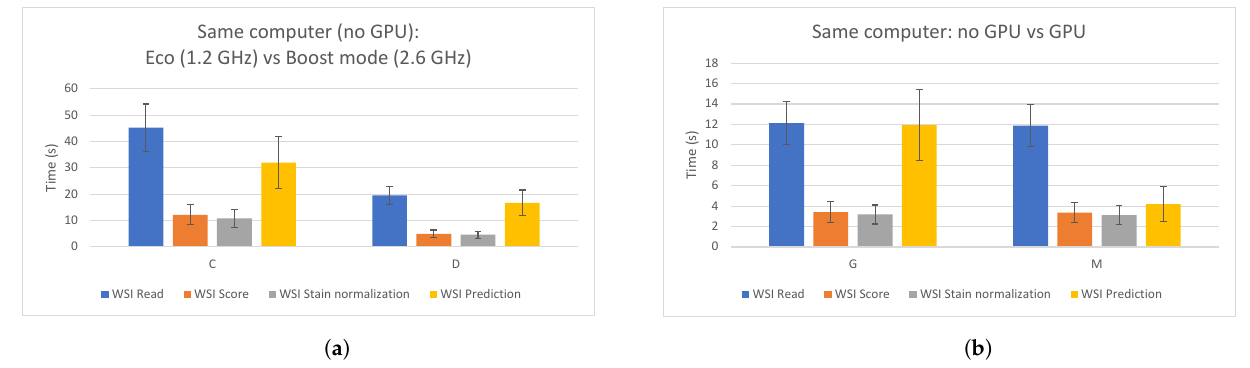
Figure 7. Impacts of the CPU and the GPU in the different WSI processing steps. ( a ) Same PC, different CPU frequency. Left: 1.2 GHz; right: 2.6 GHz. ( b ) Same PC. Left: without using GPU; right: using